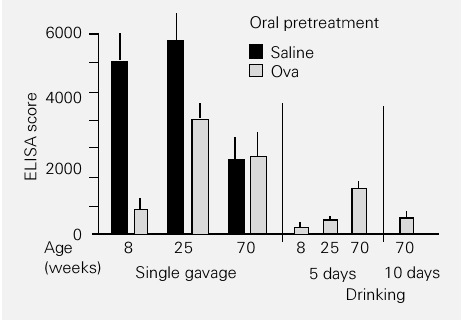
Figure 4 - Voluntary ingestion of antigen on consecutive days is more effective than a single ga- vage for oral tolerance induction. B6D2F1 mice of different ages were treated either by a single gavage administration of 20 mg ovalbumin (Ova) or by voluntary ingestion of a solution of 4 mg/ ml Ova in drinking water for 5 to 10 days. The animals were im- munized 7 days after the last oral treatment and boosted 14 days thereafter. ELISA scores and sig- nificance were calculated as de- scribed in the legend to Figure 1. Only 8-week-old (P<0.001) and 25-week-old mice (P<0.025) could be made tolerant by a single gavage administration of Ova, whereas voluntary inges- tion was effective for all groups treated with Ova